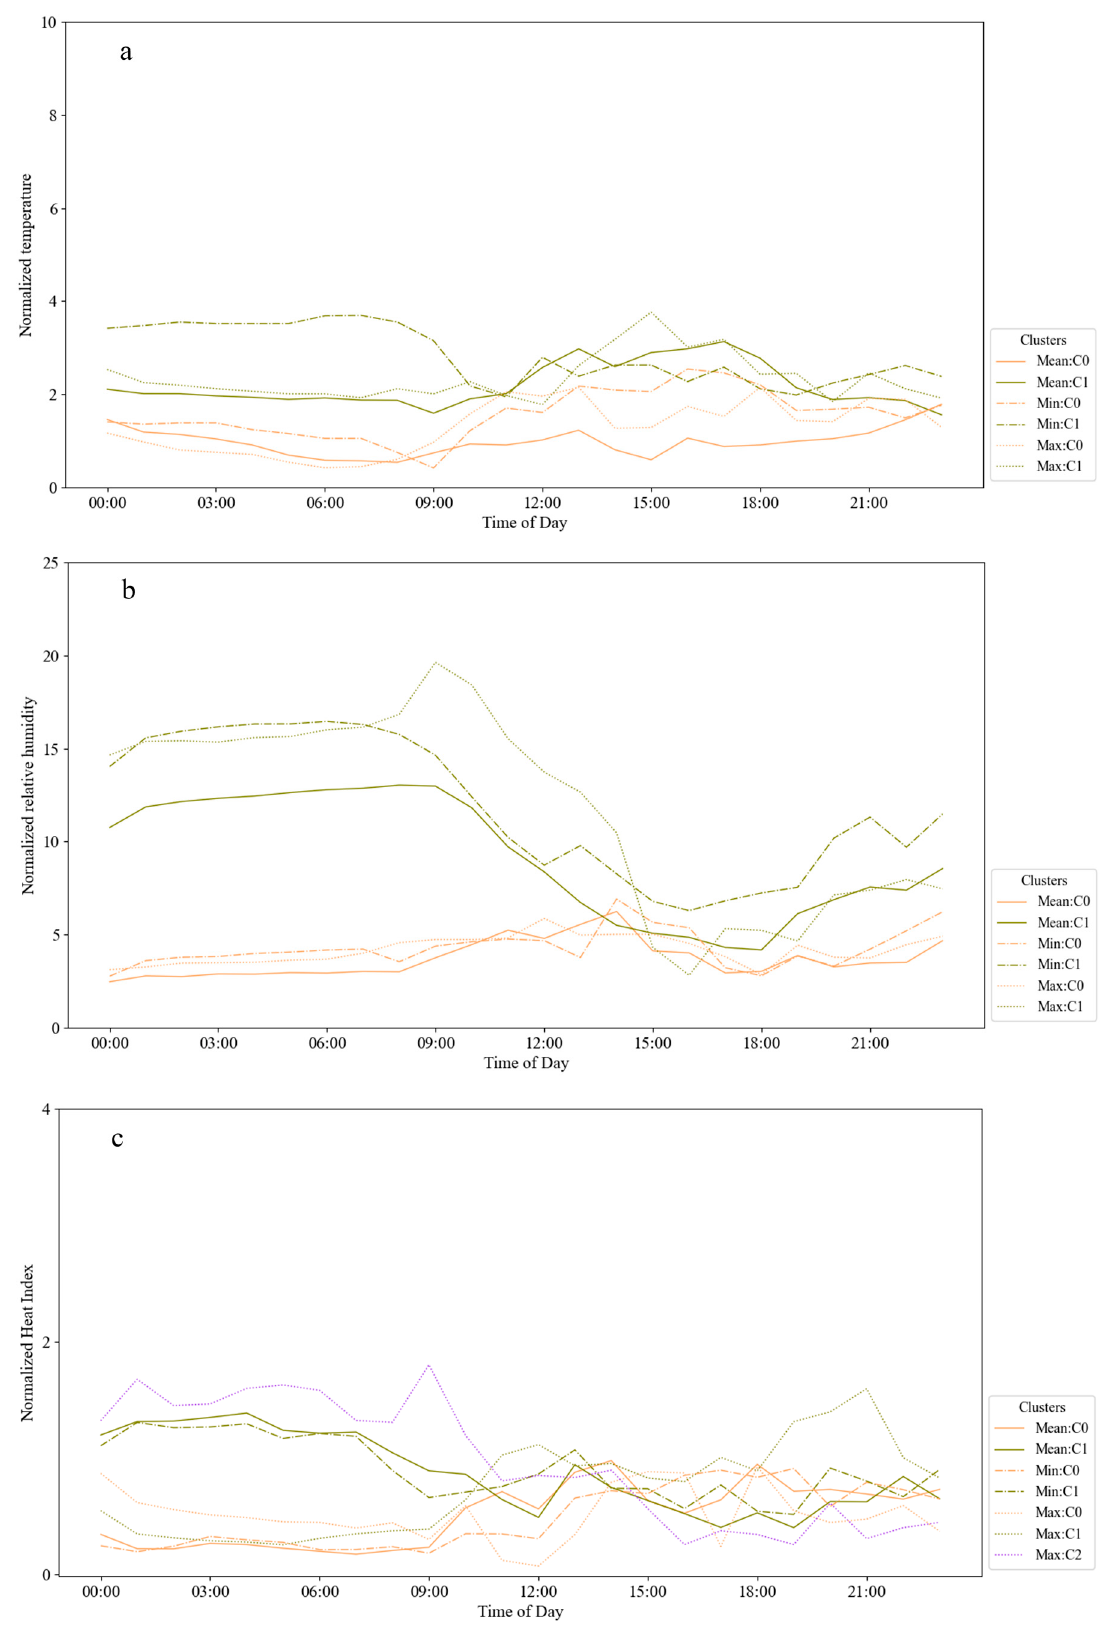
Figure 7. Daily temperature ( a ), relative humidity ( b ), and heat index ( c ) profiles for subject I. Each color line represents an index type, and the dash type shows the cluster.